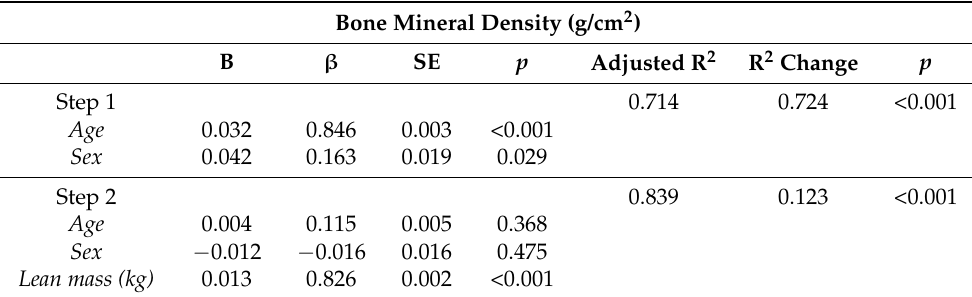
Table 5. Stepwise regression analysis assessing the independent association of Mediter- ranean Diet adherence and body composition components with bone mineral density in children with celiac disease ( n =